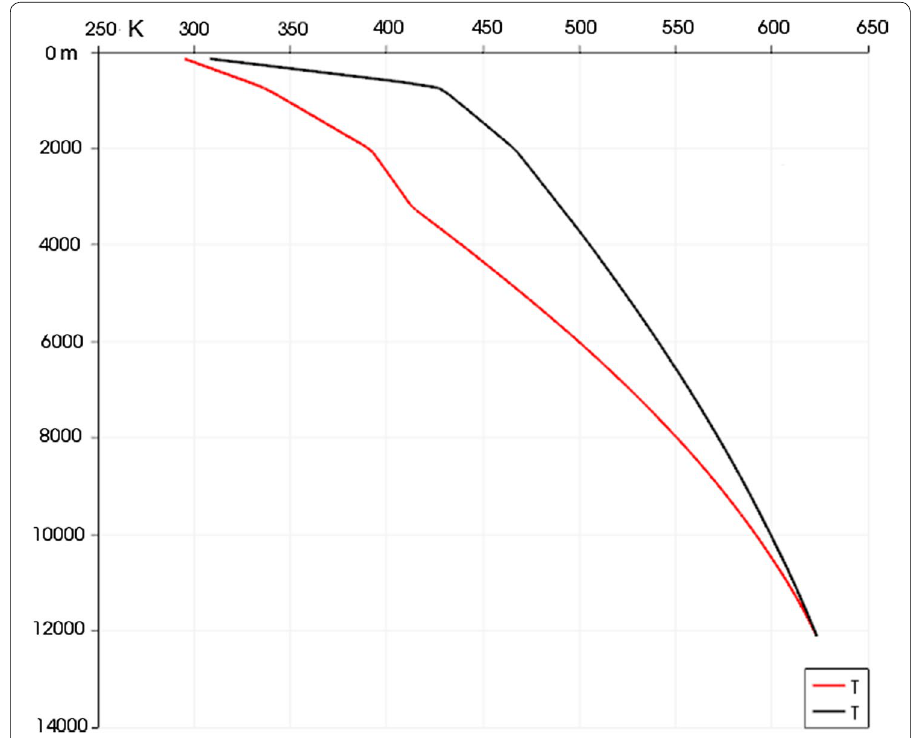
Fig. 13 Geotherm comparison for temperature-dependent and non-temperature-dependent thermal conductivity values. Black line represents non-temperature-dependent thermal conductivity while the red line represents temperature-dependent thermal conductivity for profile 3, 110 km along the x -axis (Figs. 9 and 10). The ends of each line meet as they share the same boundary conditions of 15 °C at the surface and 350 °C at the